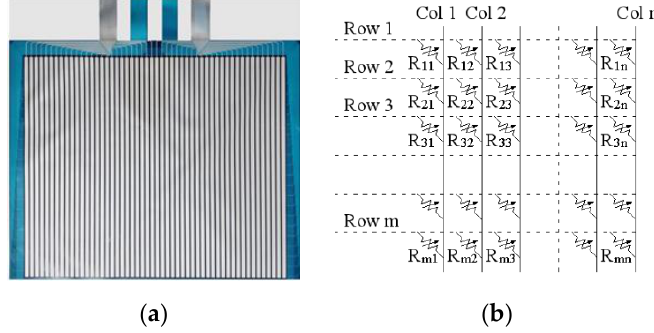
Figure 3. Flexible membrane pressure sensor. ( a ) Flexible membrane pressure sensor. ( b ) Equivalent circuit of sensing points.